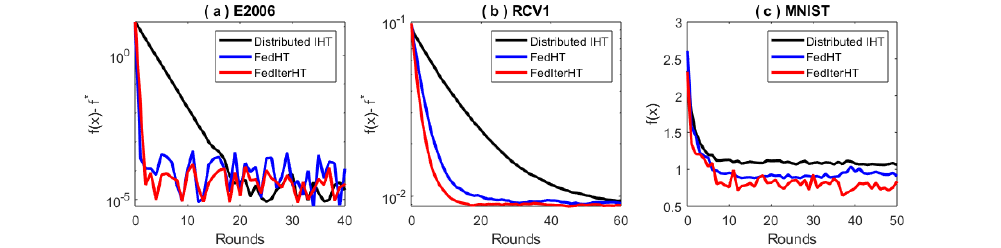
Figure 6. Comparison of the algorithms on different datasets in terms of the objective function value vs. communication rounds. f ∗ is a lower bound of f ( x ) . FedIter-HT performs consistently better across all datasets, which confirms our theoretical